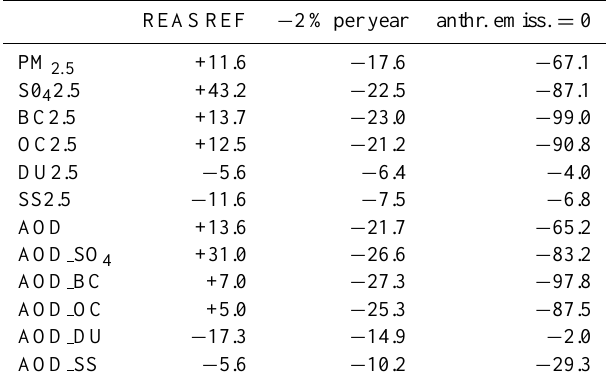
Fig. 16. Surface PM 2 . 5 (in units µgm − 3 ) and AOD (unitless) for India and China in the cases: no anthropogenic emissions (dot- ted line), 2006 emissions (dot-dot-dashed line), REAS reference scenario for 2020 (dashed line) and the − 2% per year scenario (solid line), four-year average (2006–2009 for cases with no anthro- pogenic emissions and 2006 emissions and 2020–2023 for cases with REAS reference scenario and − 2% per year scenario emis- sions).